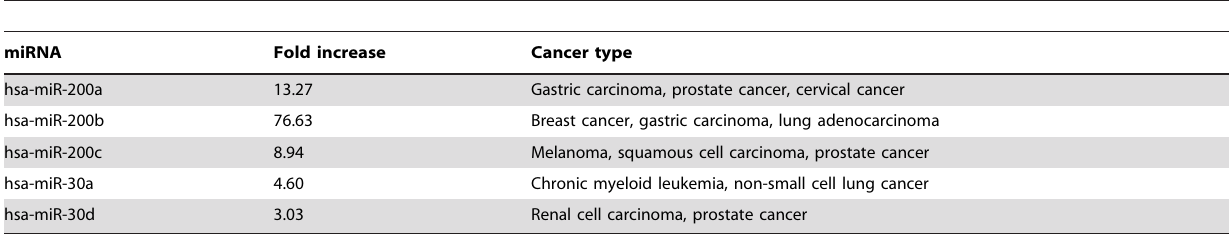
Table 1. miRNA increased with AR expression and inhibitory effect in cancers with increased expression (p , 0.05).